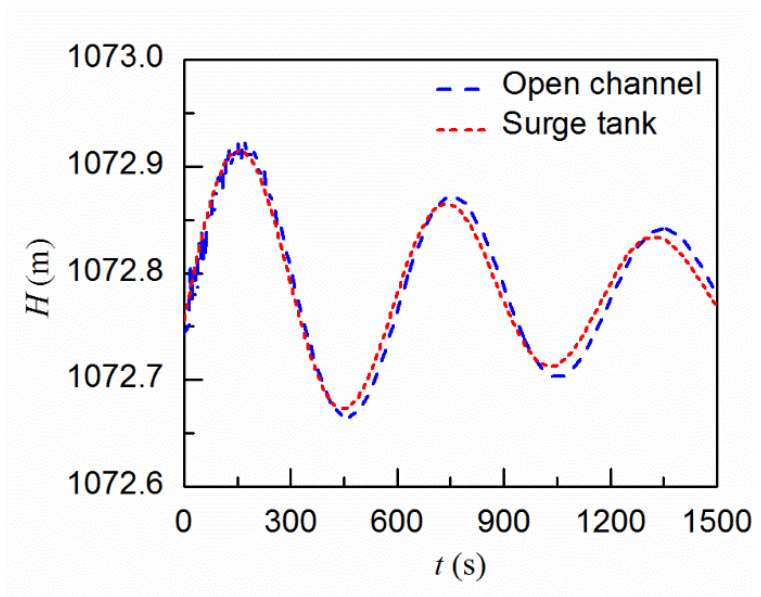
Figure 17. Comparison of the water level fluctuations in the sand basin with different modelling methods ( L 1 = 2000 m, h = 10 m, w = 10 m).